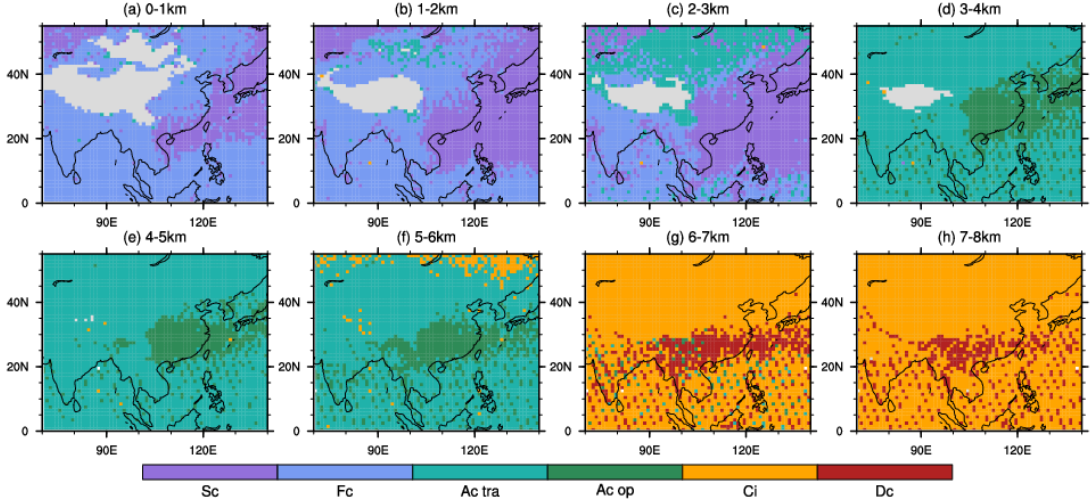
Figure 6. Horizontal distribution of the prevailing cloud type at different altitude layers: ( a ) 0–1 km, ( b ) 1–2 km, ( c ) 2–3 km, ( d ) 3–4 km, ( e ) 4–5 km, ( f ) 5–6 km, ( g ) 6–7 km and ( h ) 7–8 km